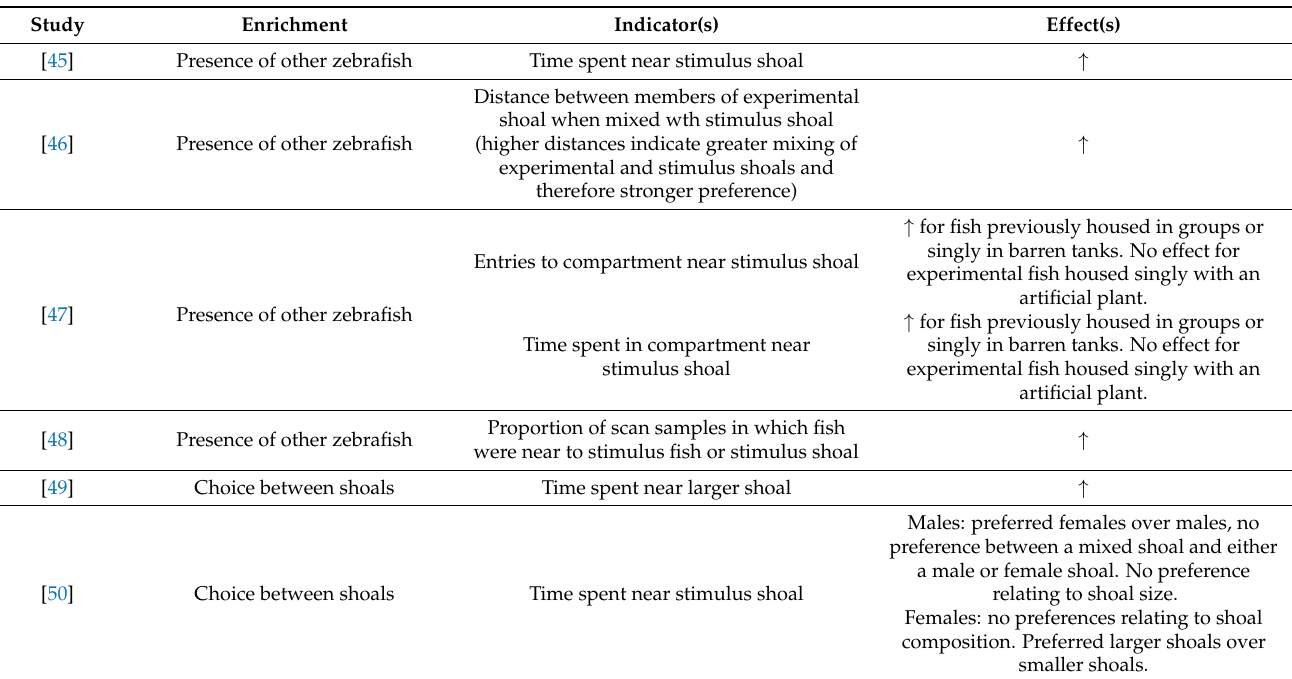
Table 1. Key results of studies relating to social enrichment for laboratory zebrafish. Studies have been included where they have either addressed a preference (such as might be used to identify conditions which might promote welfare), or tested the effects of a condition intended to provide enrichment. Unless otherwise specified, all results here relate to the presence of the enrichment condition noted in the table compared with an absence of that